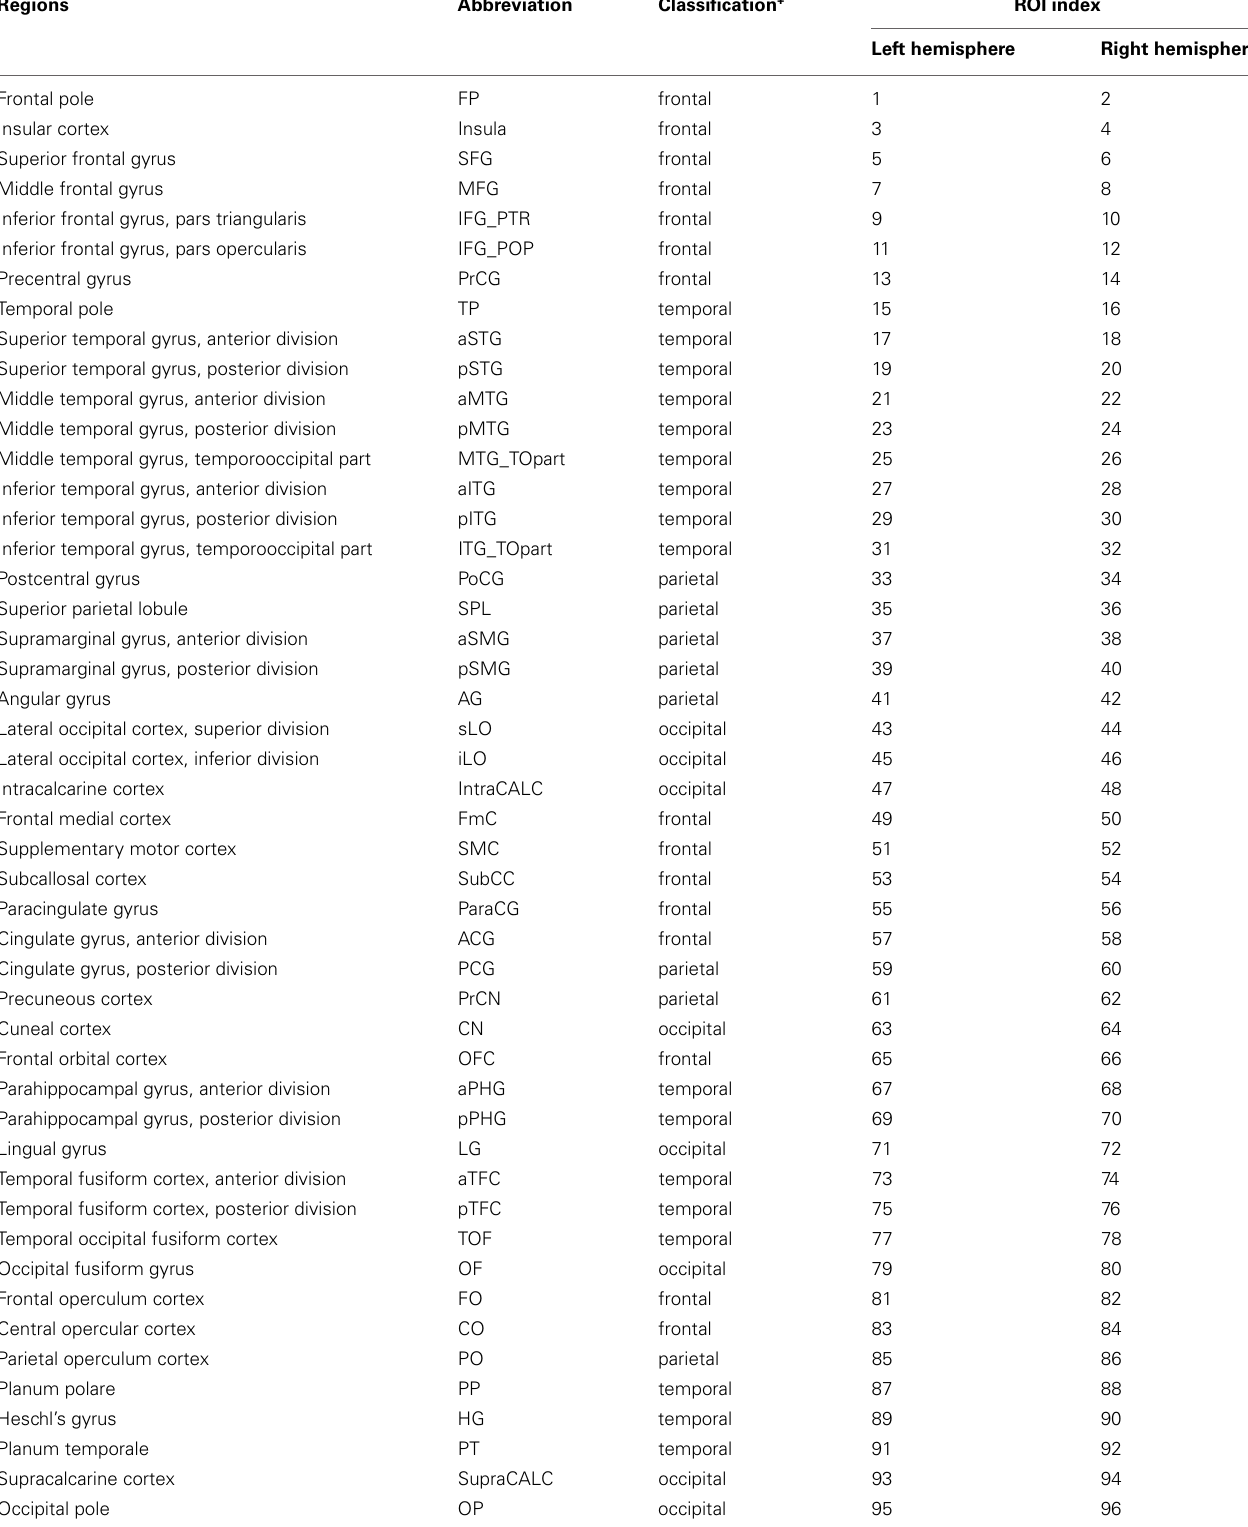
Table 3 | Anatomic regions-of-interest included in the network analysis †